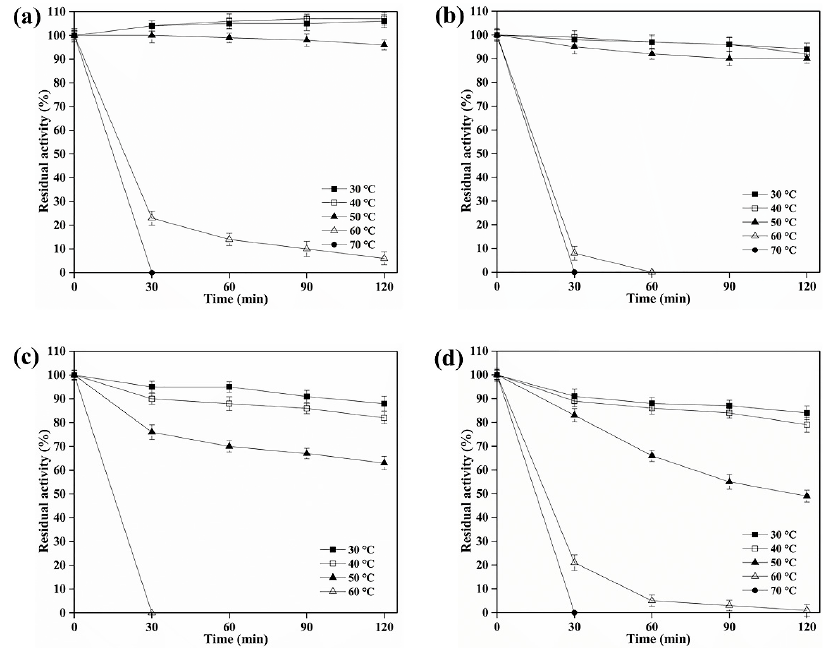
Figure 2. The thermostability of recombinant TGs. The effect of temperature on the stability of ( a ) BAMTG, ( b ) BCETG, ( c ) BSATG, and ( d ) BARTG. Three independent experiments were performed to calculate the values described by means ± SD.